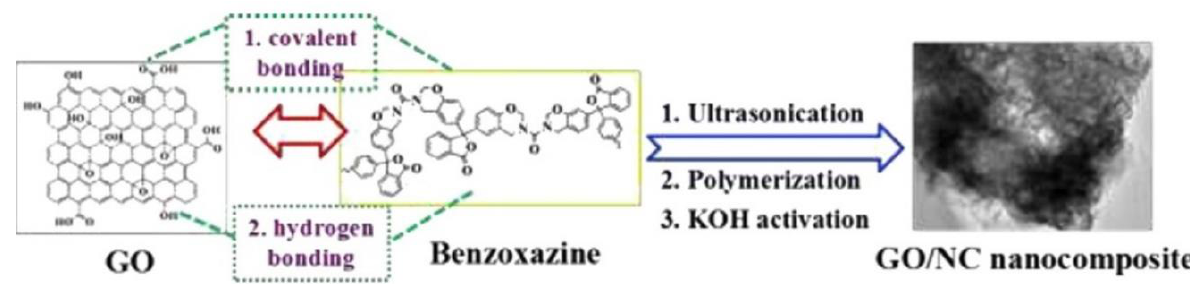
Figure 32. GO/NC nanocomposites prepared from a novel polybenzoxazine (reproduced from the work in [81] with permission).